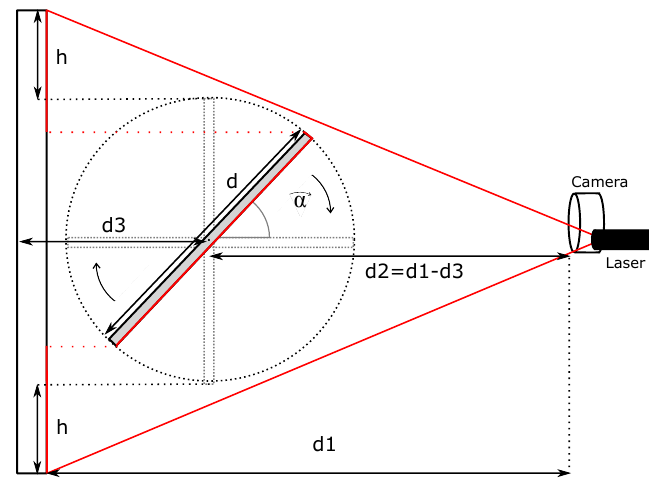
Figure 12. Rotating stick experiment. ( a ) Stick side fully illuminated by the laser (minimum distance to the camera); ( b ) Background mostly illuminated by the laser (maximum distance to the camera); ( c ) Overall experiment set-up view with the rotating stick.